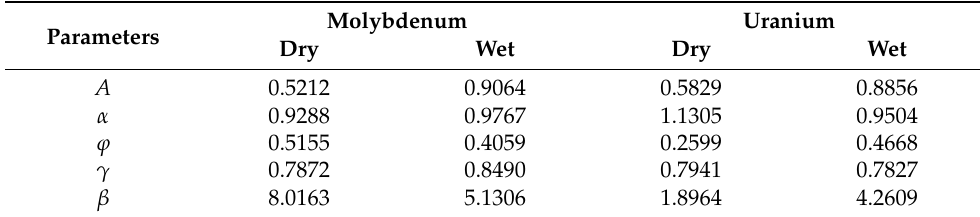
Table 2. Parameters used for calculating S and B showing the best fit with the experimental data obtained from batch grinding